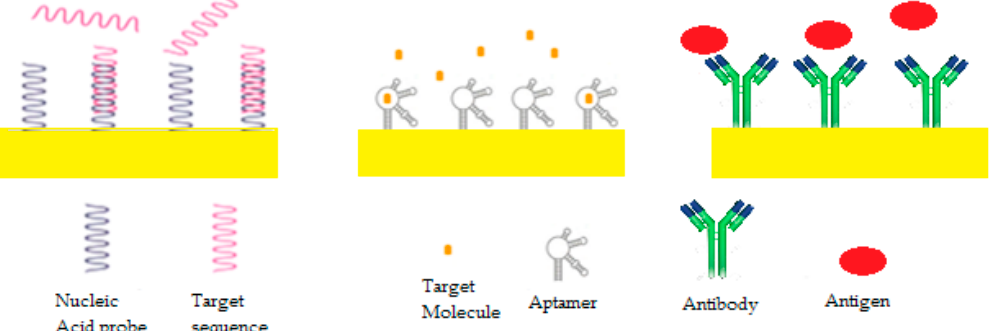
ffi nity sensors (AS) design